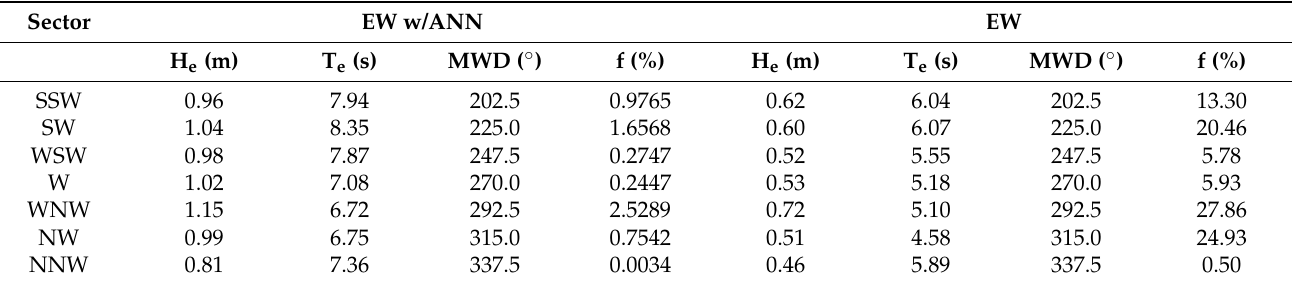
Table 4. Obtained representative sea-states by implementing the proposed methodology (EW